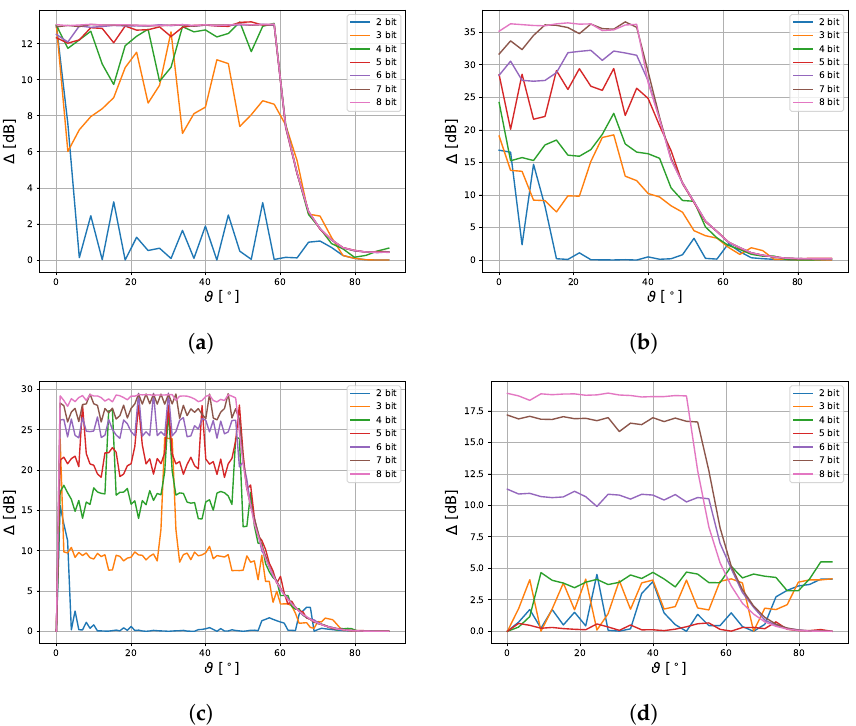
Figure 8. The influence of quantization of coefficients. ( a ) Fourier method with rectangular window; ( b ) Fourier method with Hamming window; ( c ) Dolph–Chebychev with required side lobe level − 30 dB; and ( d ) Zero placement method.